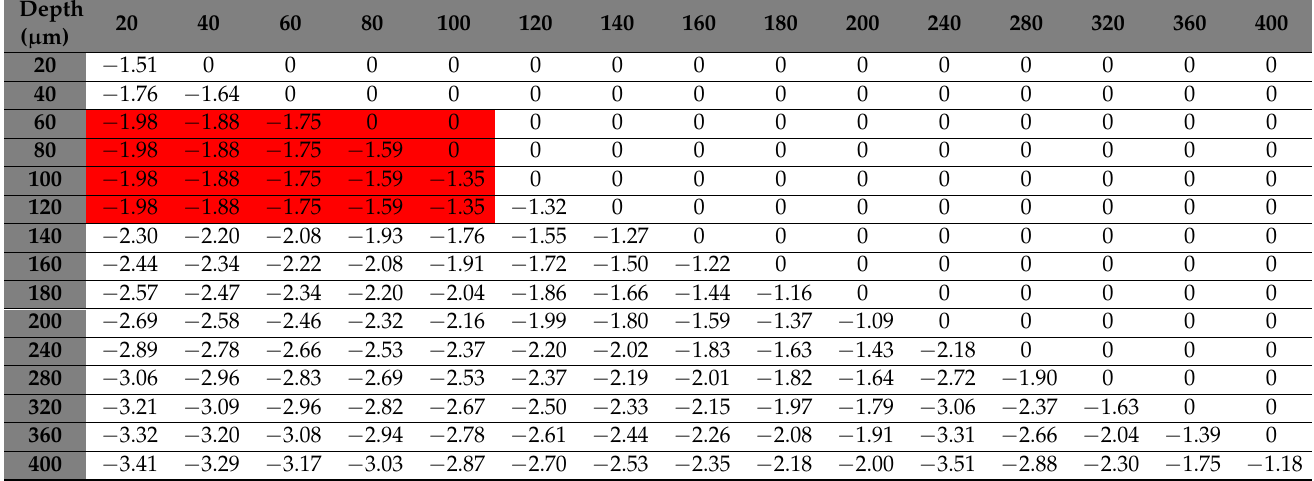
Table 2. Calculated coefficients C 11ij of unidirectional CFRP under consideration of